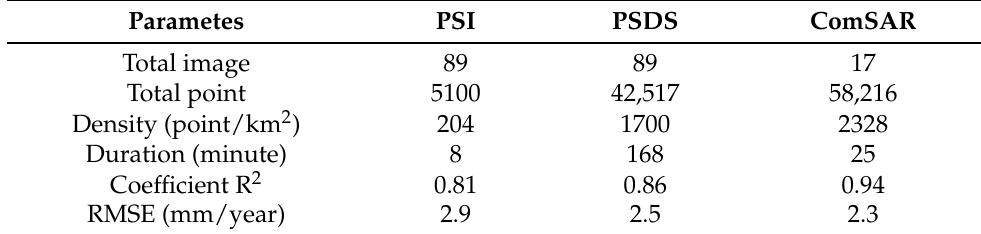
Table 1. Characteristics of